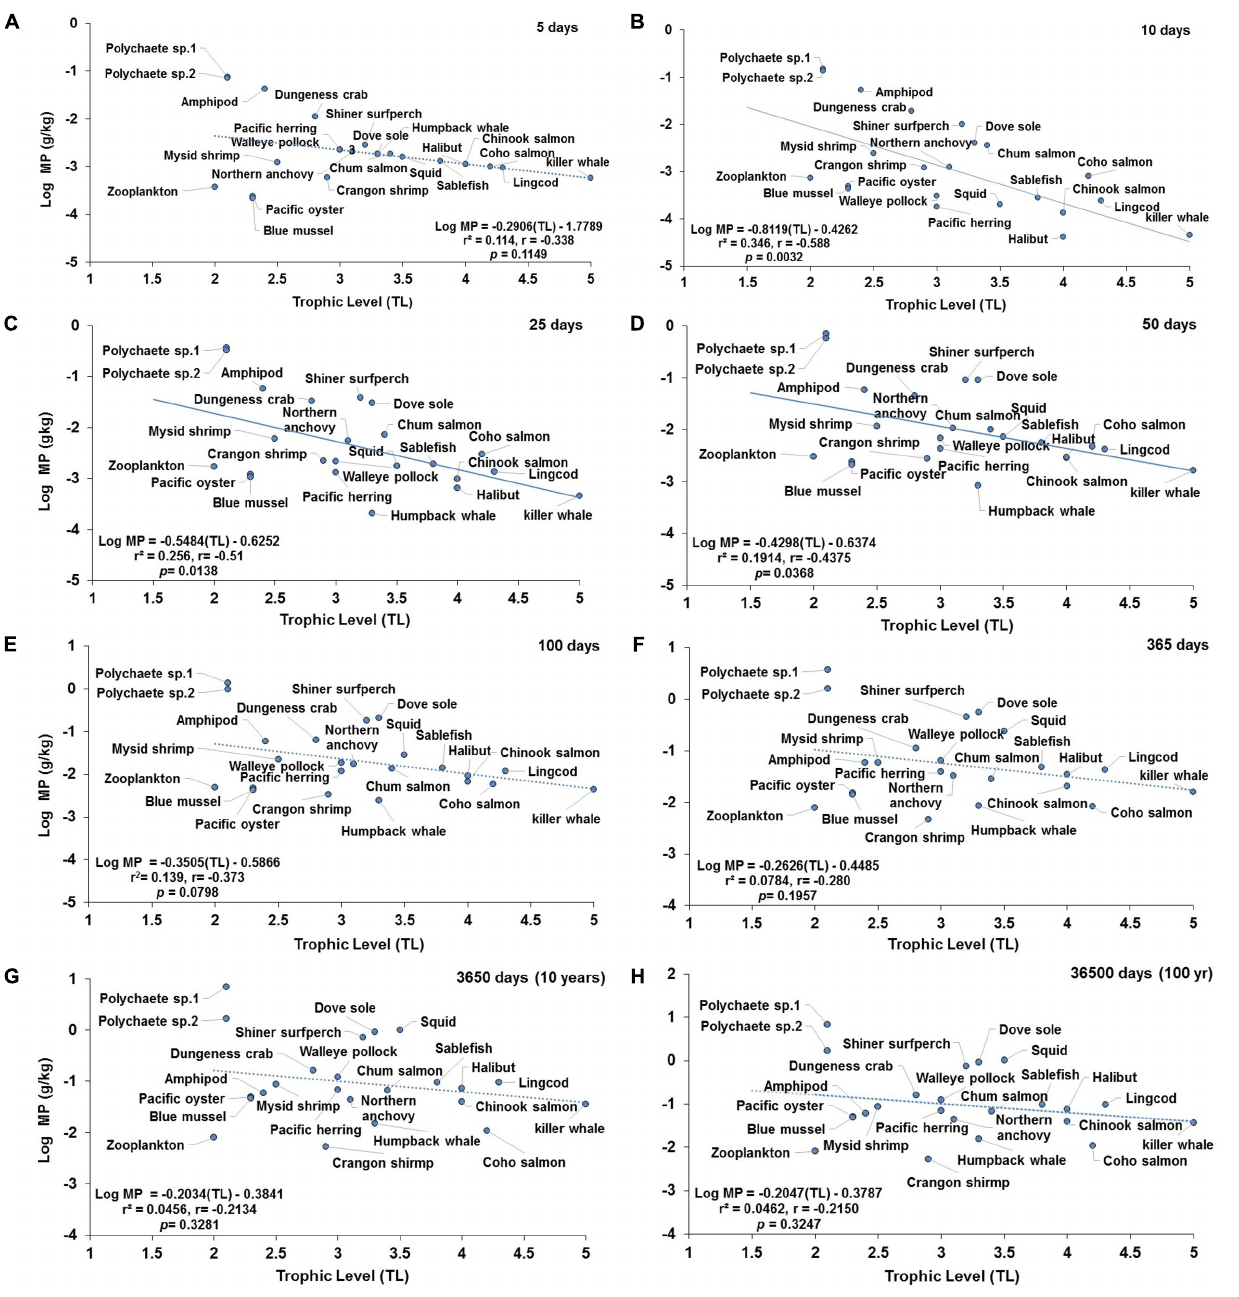
found for organic contaminants that are slowly metabolized or eliminated by animals, i.e., metabolic rate ( k M ) < 0.01/d (Walters et al., 2016). TMFs of organic contaminants are